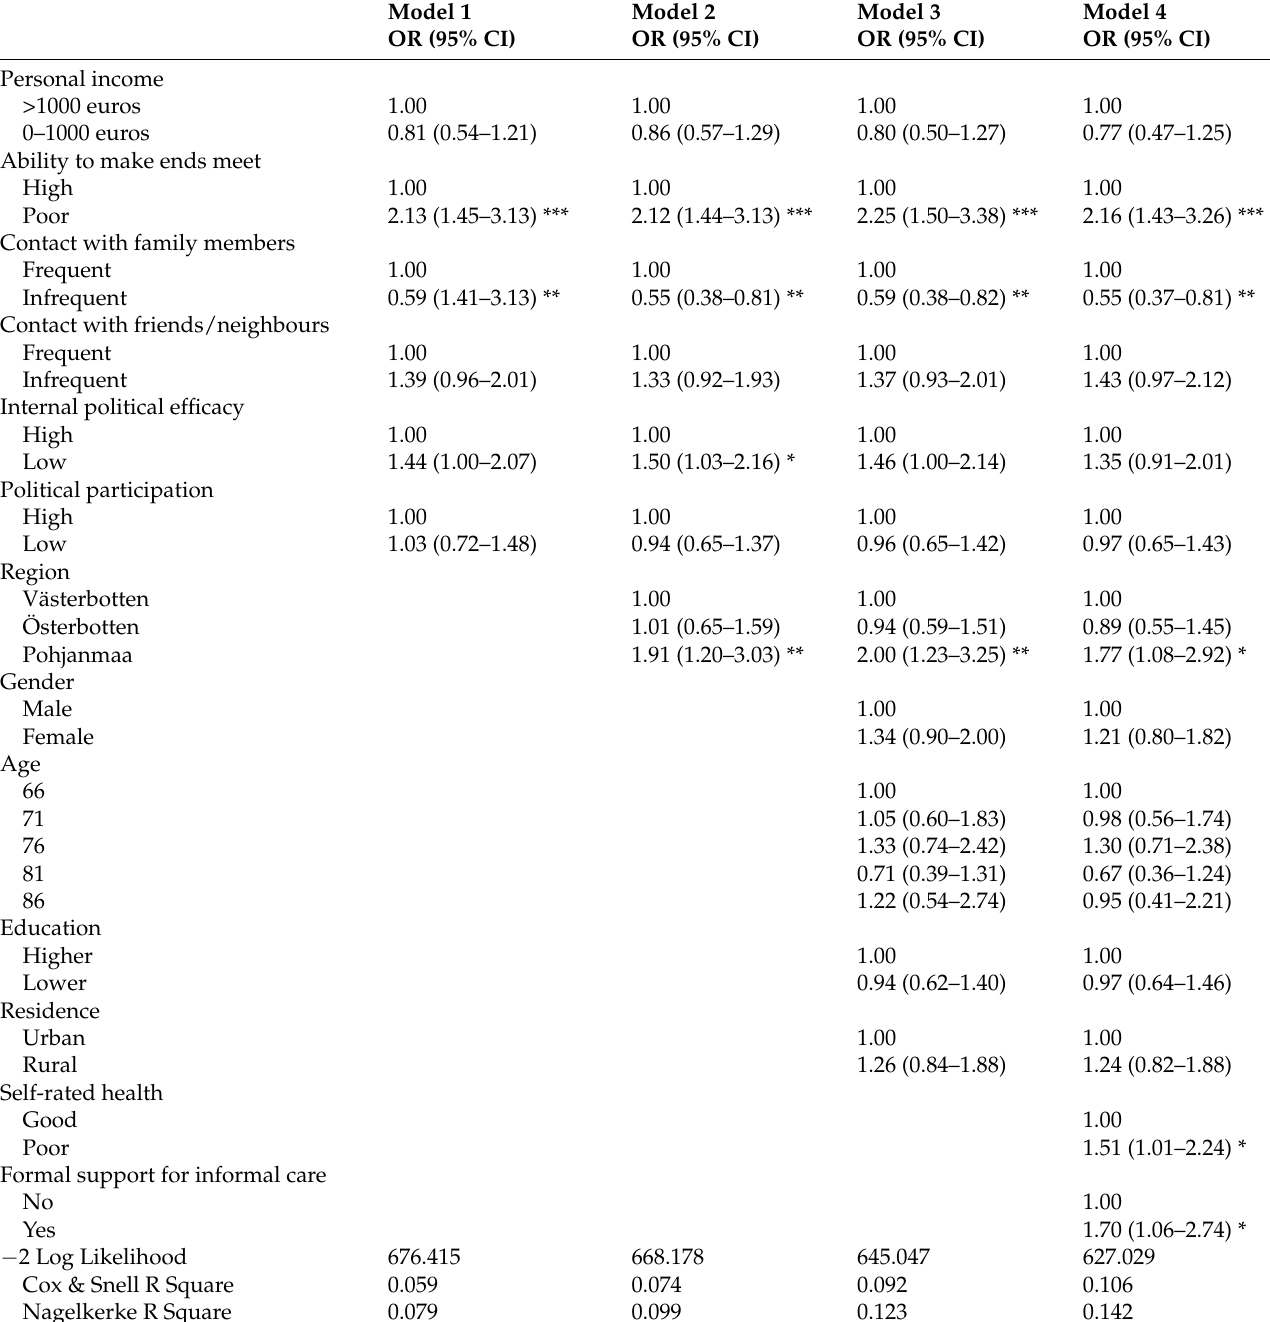
Table 3. Odds Ratios (OR) and 95% confidence intervals (CI) for subjective caregiver burden among older spousal caregivers (n = 673) in Västerbotten (Sweden), Swedish-speaking Österbotten (Finland), and Finnish-speaking Pohjanmaa